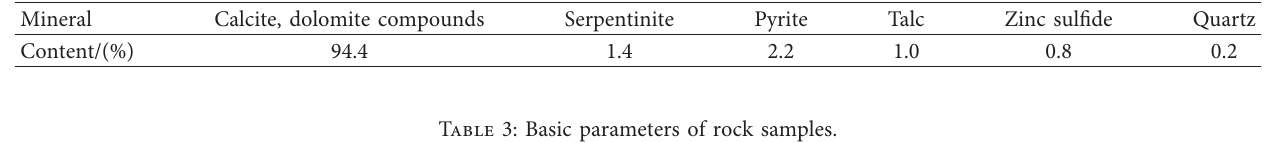
Table 2: Mineral composition of the limestone.